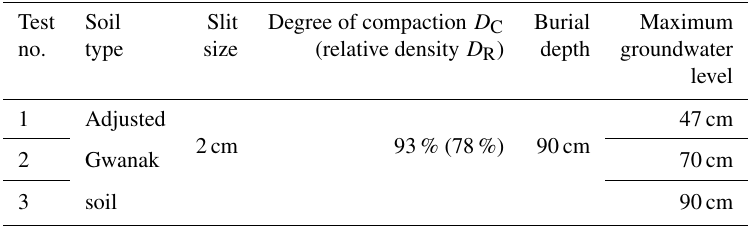
Table 3. Model test conditions used in this